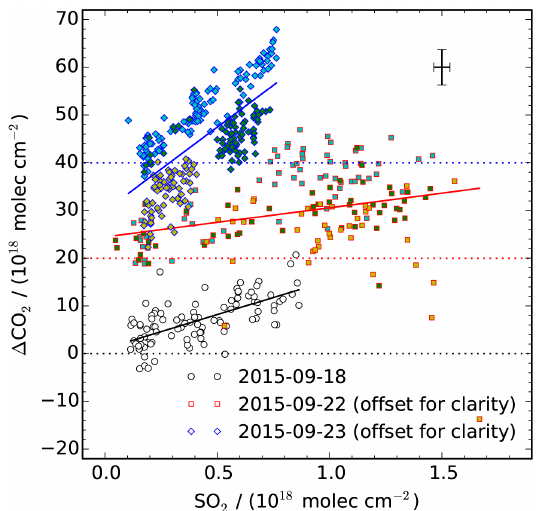
Figure 11. Same as Fig. 10 but for SO 2 and HF VCDs. For clarity, data on 22 and 23 September are offset in ordinate by 0.5 × 10 18 and 1.0 × 10 18 moleccm − 2 , respectively, as indicated by the col- ored dotted